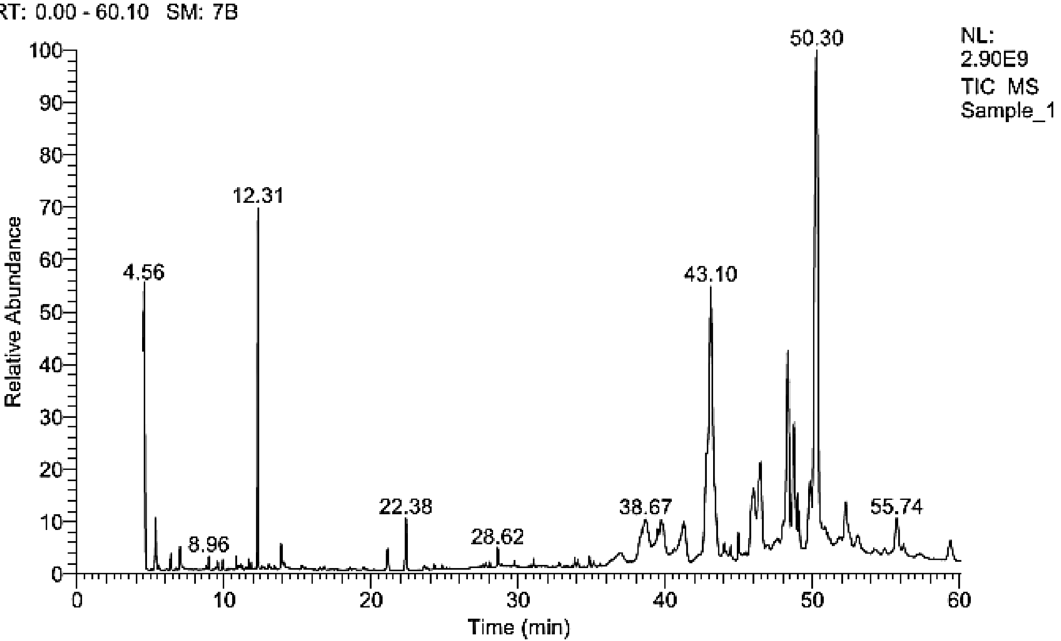
Figure 9. GC/MS profile of fatty acid methyl esters (biodiesel) produced from the enzymatic transesterification and enzymatic esterification process of cooking oil